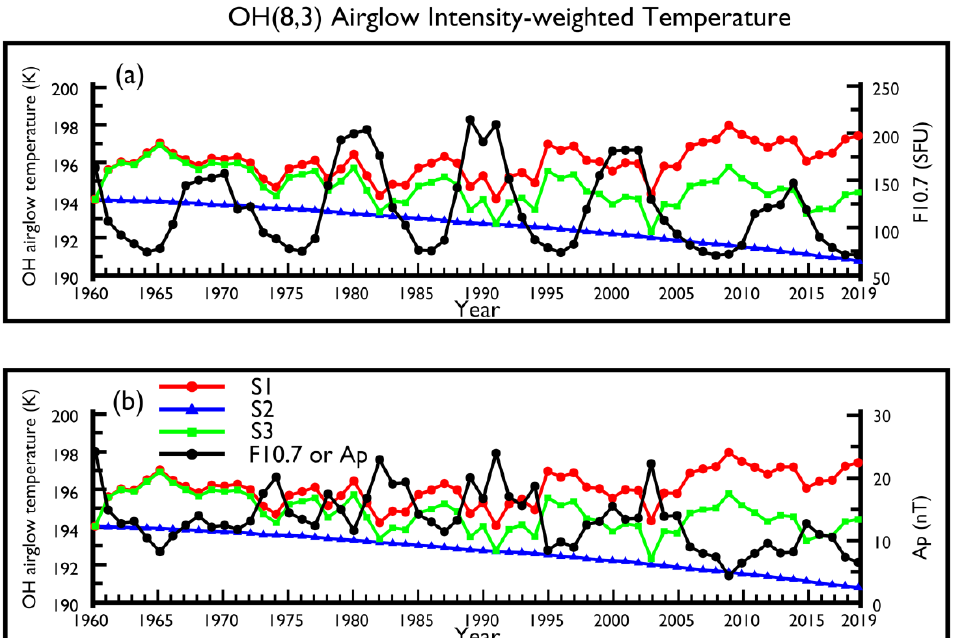
Figure 1. ( a ) Time series of the simulated OH temperature (axis on left) and F10.7 (axis on right) in the top panel for the three scenarios. ( b ) The same plot but with Ap index (axis on right) is on the bottom panel. The red line with dots denotes the first scenario S1. The blue line with upright triangles denotes the second scenario S2. The green line with squares denotes the third scenario S3. The solid line with diamonds denotes either F10.7 or Ap index.